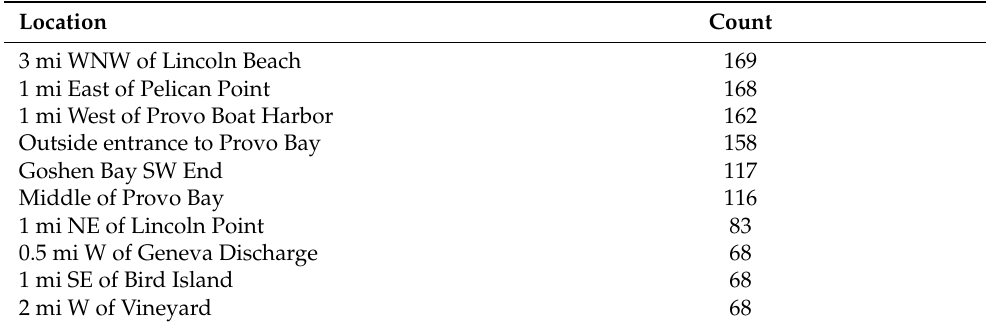
Table 6. The ten most sampled locations and number of chl-a samples from the DEQ AWQMS data base.